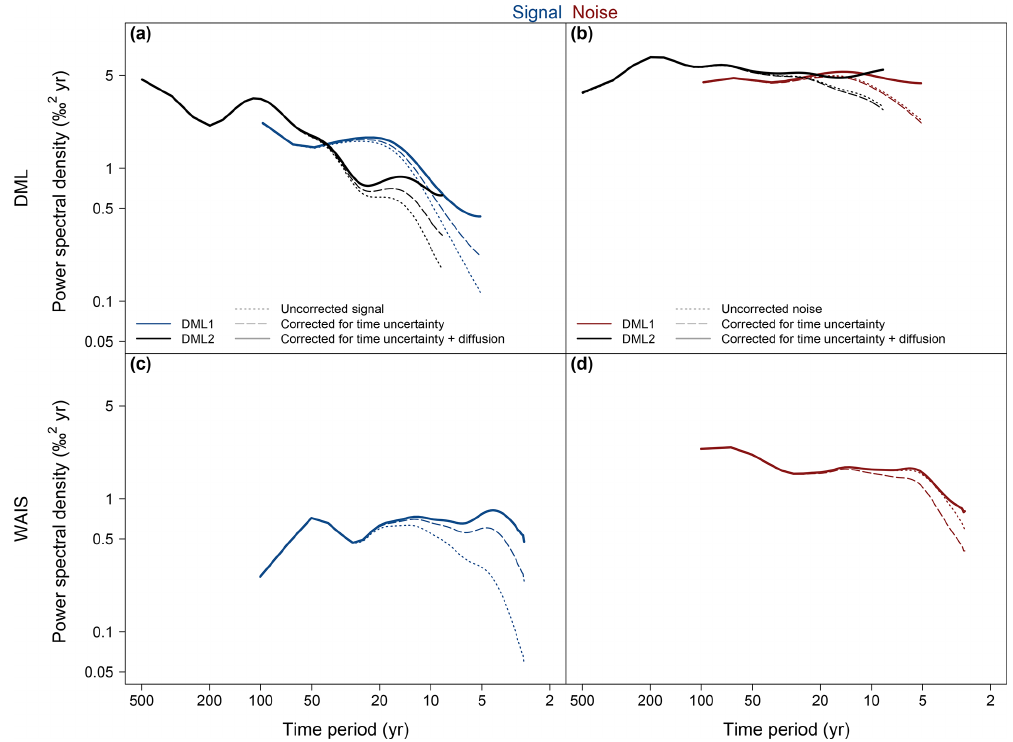
Figure 2. Estimated signal (a, c) and noise (b, d) spectra of Antarctic isotope records. Results are shown based on the spectral correction model for the records from Dronning Maud Land (DML, a , b ) and from the West Antarctic Ice Sheet (WAIS, c , d ). The raw estimates (dotted lines) show the spectra prior to any correction, while corrected estimates differentiate between the correction for time uncertainty only (dashed lines) and the full correction including time uncertainty and diffusion (solid lines). For DML, results include both the short 200-year-long records (DML1; blue lines in a , red lines in b ) and the longer records covering the last 1000 years (DML2; black lines).